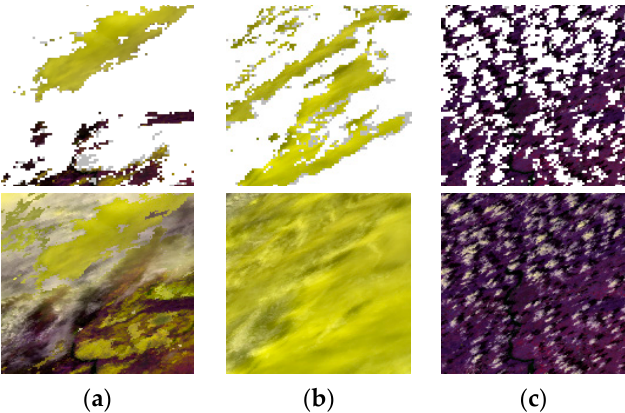
Figure 7. Examples of the more liberal cloud mask by VIIRS ( a , b ), colored in RGB according to 0.87 μ m (I2), 0.64 μ m (I1) and 1.61 μ m (I3). Top row: Overlay of the VIIRS cloud mask (white: “confidently cloudy”, gray: “probably cloudy”); the rightmost image shows river grids impacted by shadows of broken clouds casting shadows that may result in non-detections of river ice in impacted grids. Bottom: False color images corresponding to the above: ( a ) Day 355, 2013; ( b ) Day 342, 2013; and ( c ) Day 99, 2014.